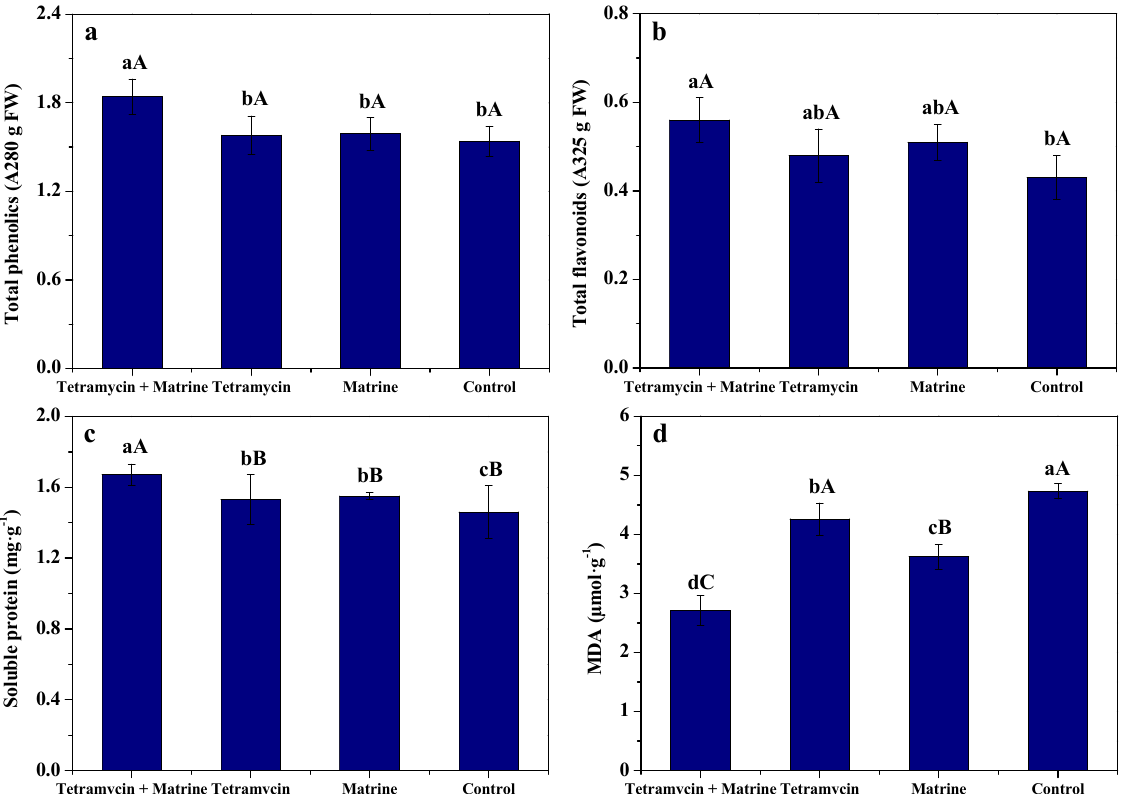
Figure 2. The effects of tetramycin and matrine on the contents of phenolics ( a ), flavonoids ( b ), soluble protein ( c ), and MDA ( d ) in kiwifruit fruits. Values indicate the mean ± SD ( n = 3). Different capital and small letters show significant differences at 1% ( p < 0.01) and 5% ( p < 0.05) levels, respectively.